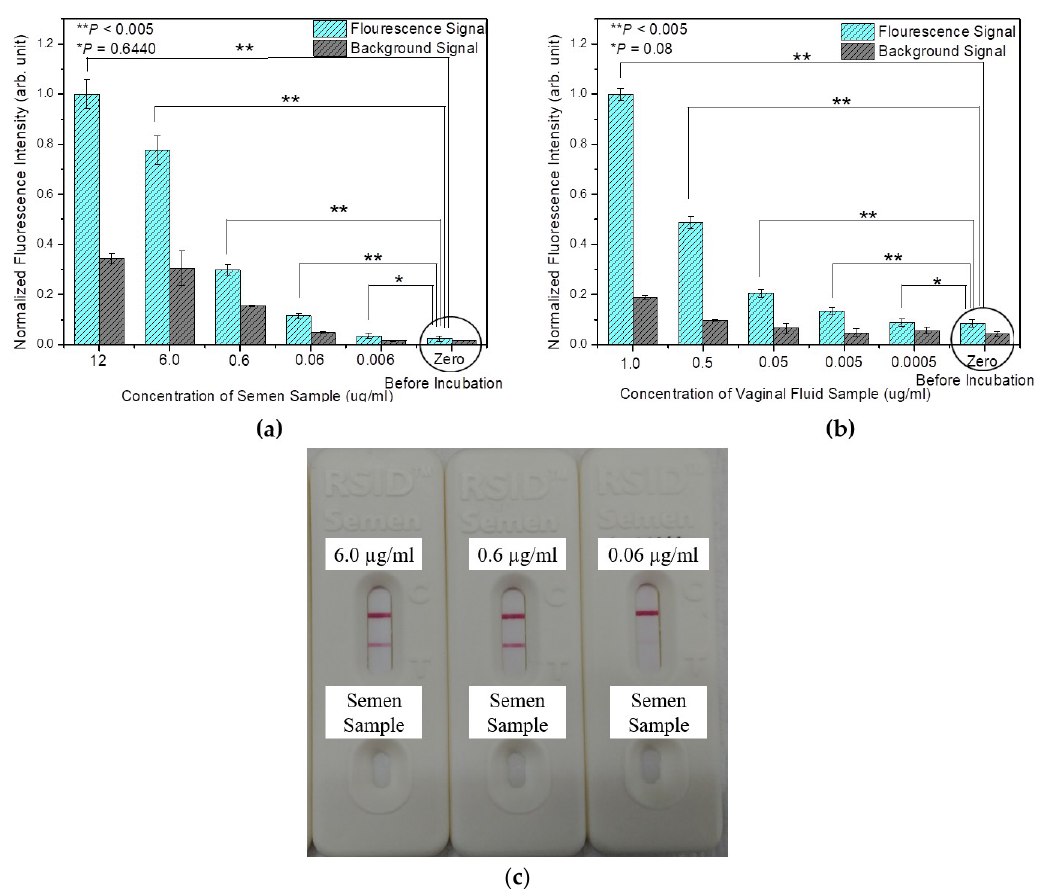
Figure 6. Limit of detection analysis results of the HSV-ID chip for ( a ) semen, ( b ) vaginal fluid, and ( c ) the limit of detection analysis results of the commercial RSID-Semen kit for semen.